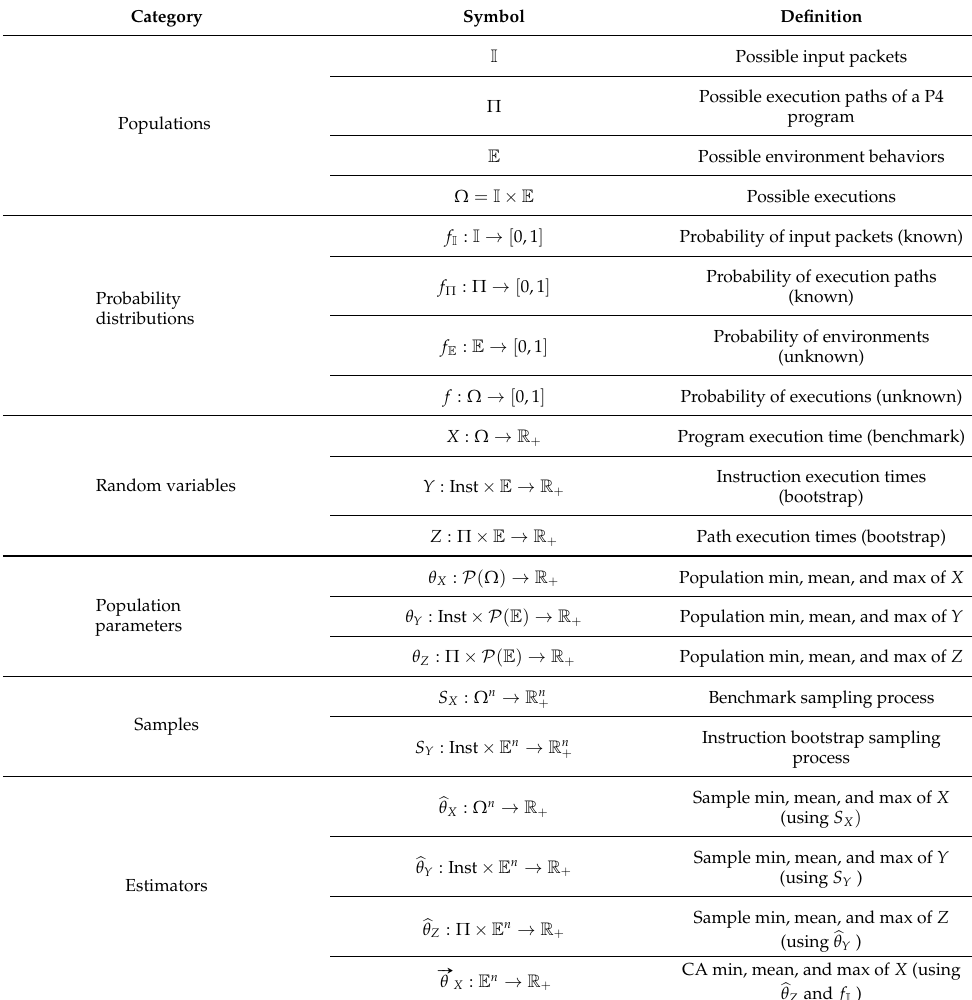
Table 1. The place of cost analysis among statistical concepts used in conventional